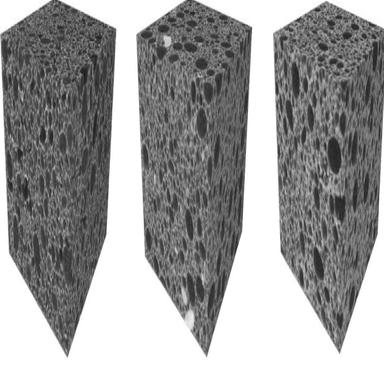
l-CT microstructures of the LWC specimens in 3D: (a) LWAC500, (b) LWAC750, (c) LWAC1000, (d) FC500, (e) FC750, (f) FC1000.